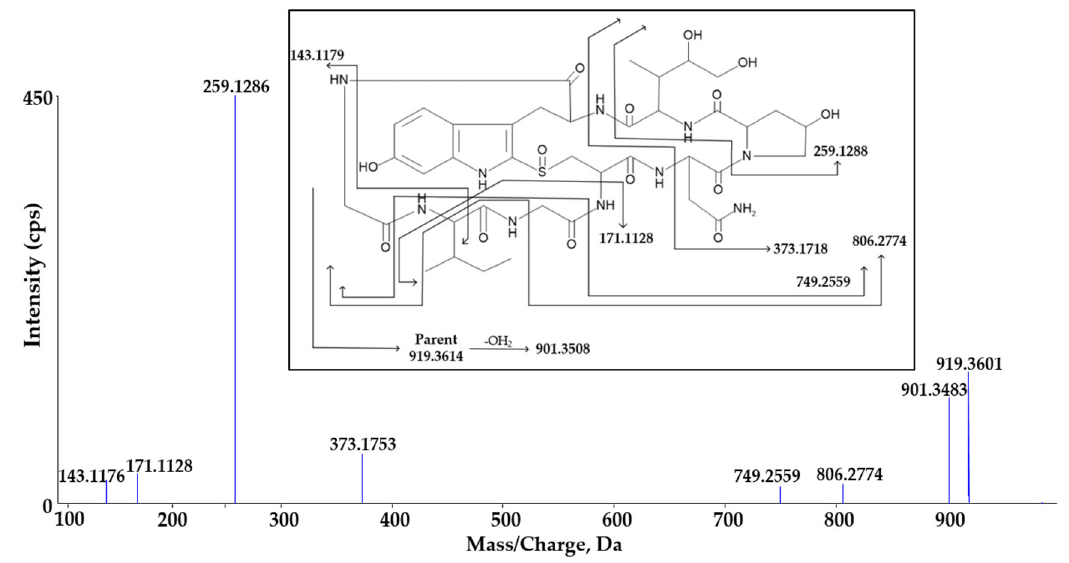
Figure 6. Fragmentation pattern of parent ion of α‐ amanitin ( m/z 919.36).